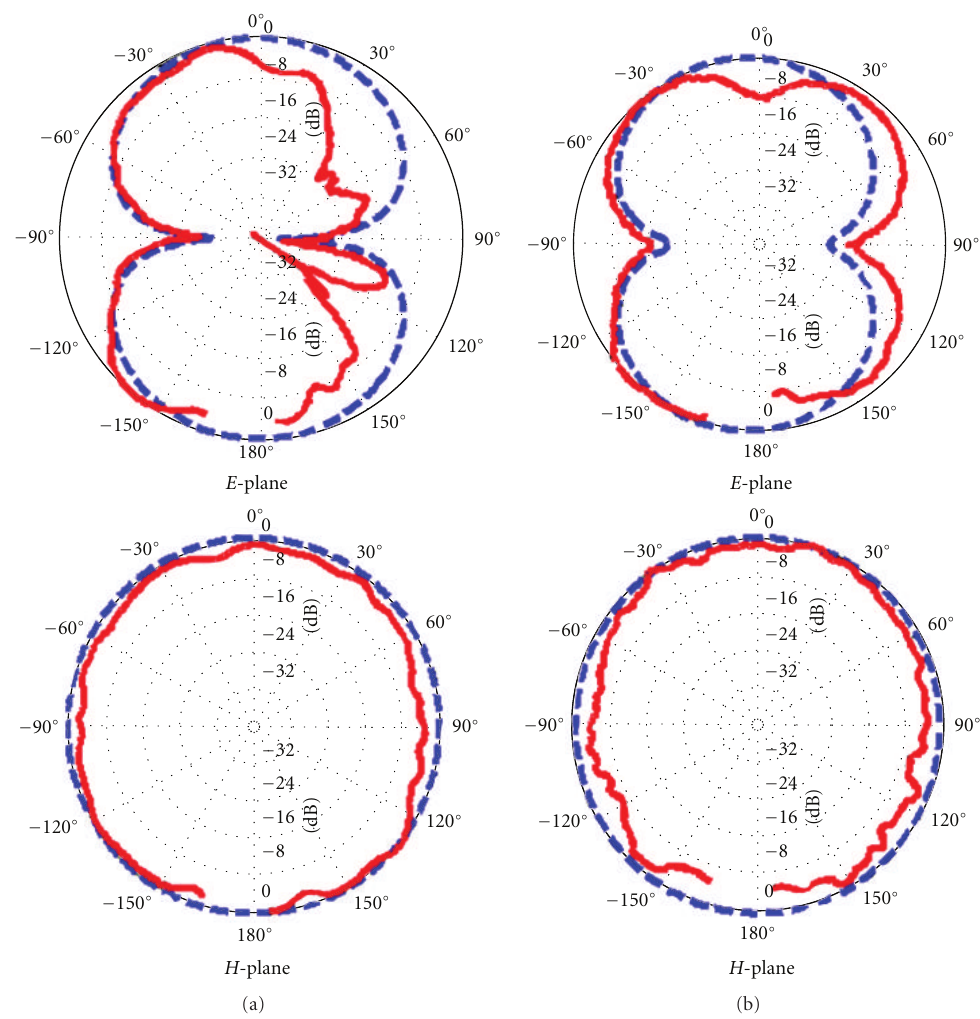
Figure 9: Simulated (dashed blue line) and measured (solid red line) normalised E -plane ( X-Y ) and H -plane ( X-Z ) radiation patterns, when the antenna is configured at: (a) 3.4 GHz in Band I and (b) 5GHz in Band II.